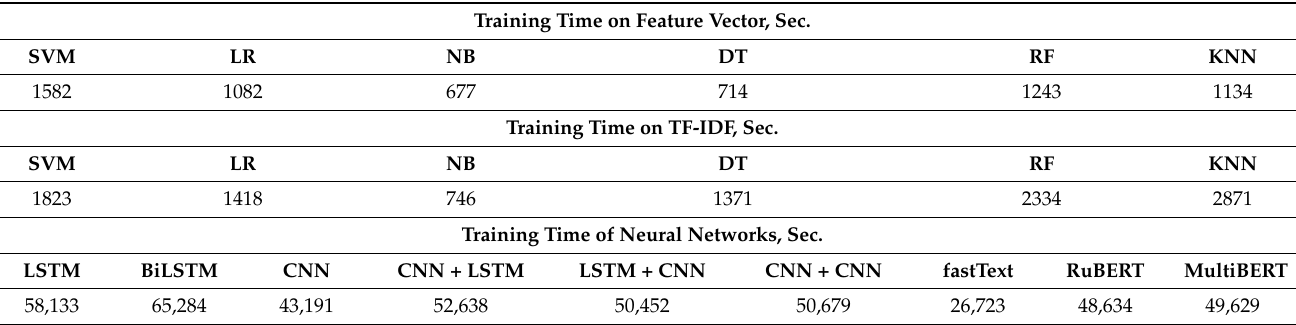
Table 6. Table 6. Training time on the dataset of 50 authors. Training Time on Feature Vector,